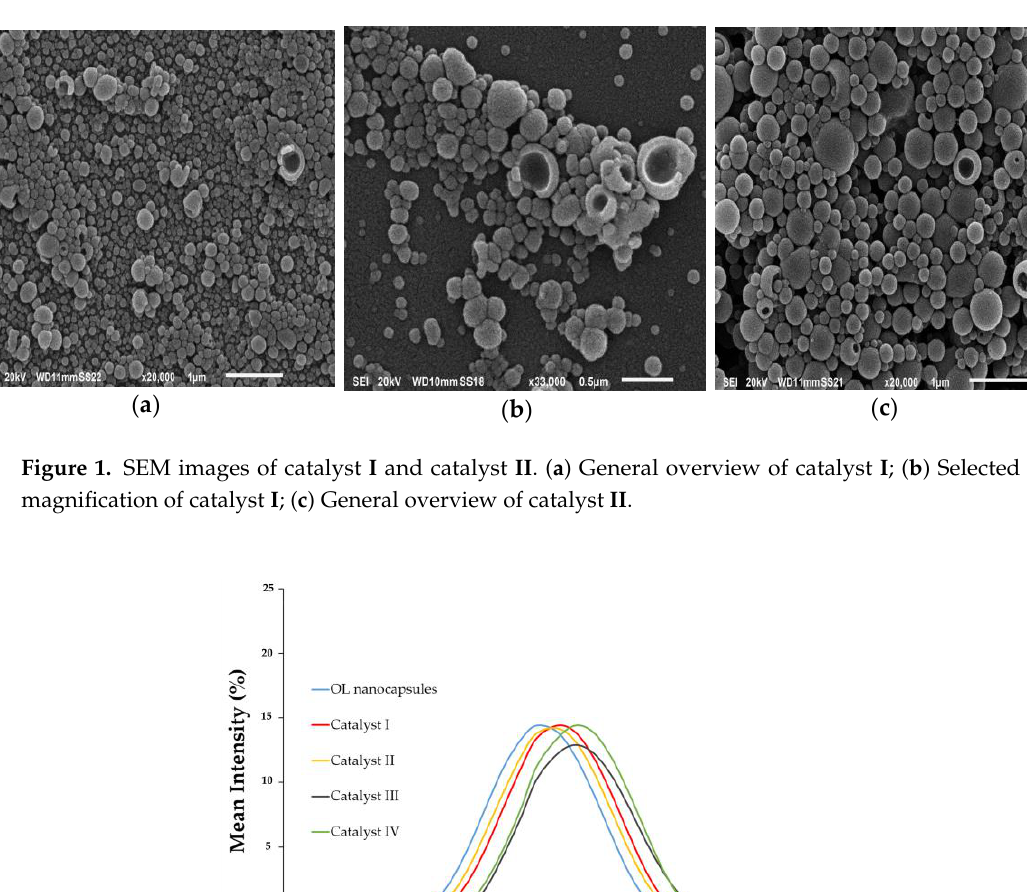
Figure 2. Representative particle diameter distributions of OL nanocapsules and Catalyst I – IV . ( a ) ( b ) Figure 3. Confocal images of ( a ) Catalyst I ; ( b ) Catalyst II .